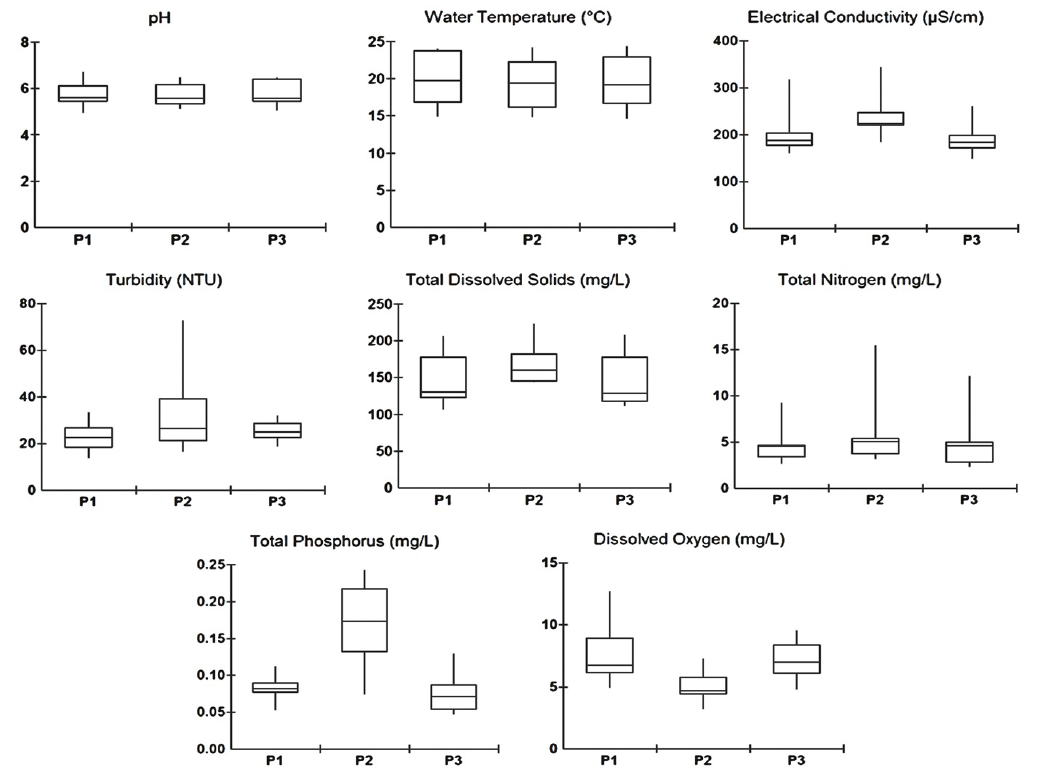
Figure 2. Abiotic variables measured at sampling sites P1 - Taquacetuba, P2 - Alvarenga and P3 - Biguás Island at Billings Reservoir (Brazil, São Paulo State) represented by box-and-whiskers plots where the lower and upper limits of the box correspond to the 25th and 75th percentiles, respectively, the whiskers correspond to the minimum and maximum, and the center line of the distribution corresponds to the